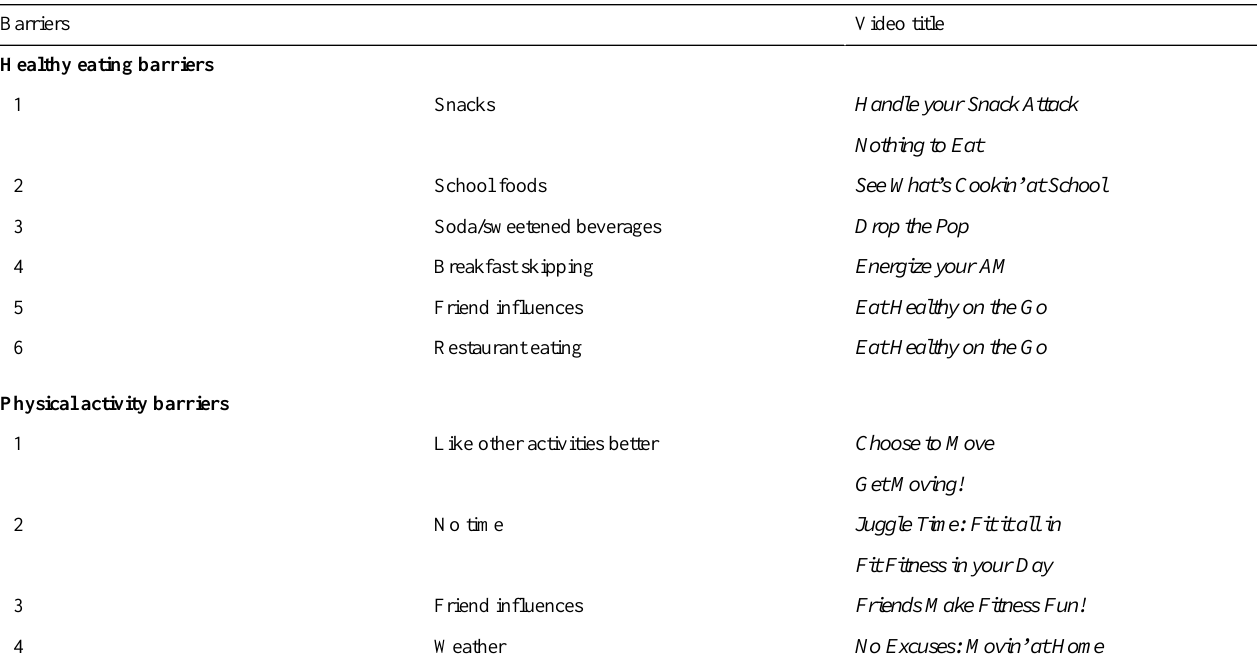
Table 3. Top barriers reported in focus groups and the videos created to address each